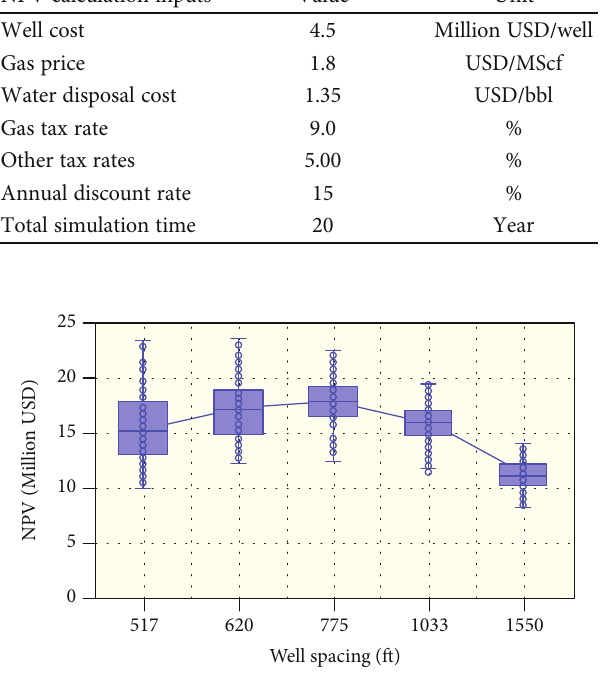
Figure 13: Economic uncertainty distribution with di ff erent well spacing scenarios.